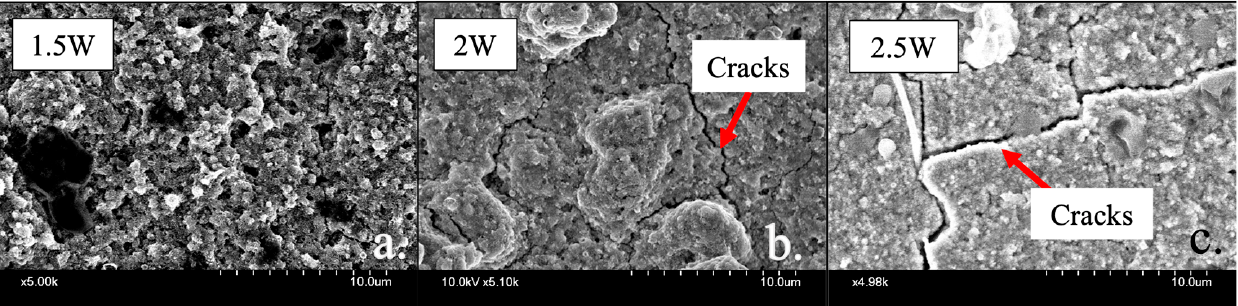
Figure 10. The SEM photographs (magnification 5k× images) of thin films were sintered by same scanning speed and frequency but with different power output. Laser parameters 100 mm/s, 105 k Hz with 1.5W ( a ), 2W ( b ) and 2.5W ( c )..